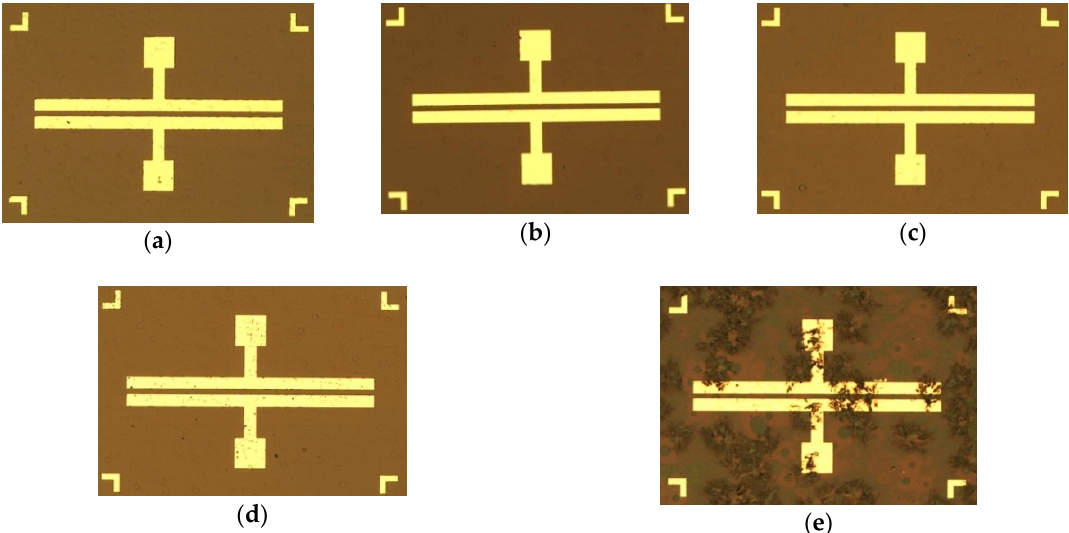
Figure 3. Images of the ( a ) MSM varactor, ( b ) MOSOM varactor (without annealing), and ( c ) MOSOM varactor (with 900 °C annealing).